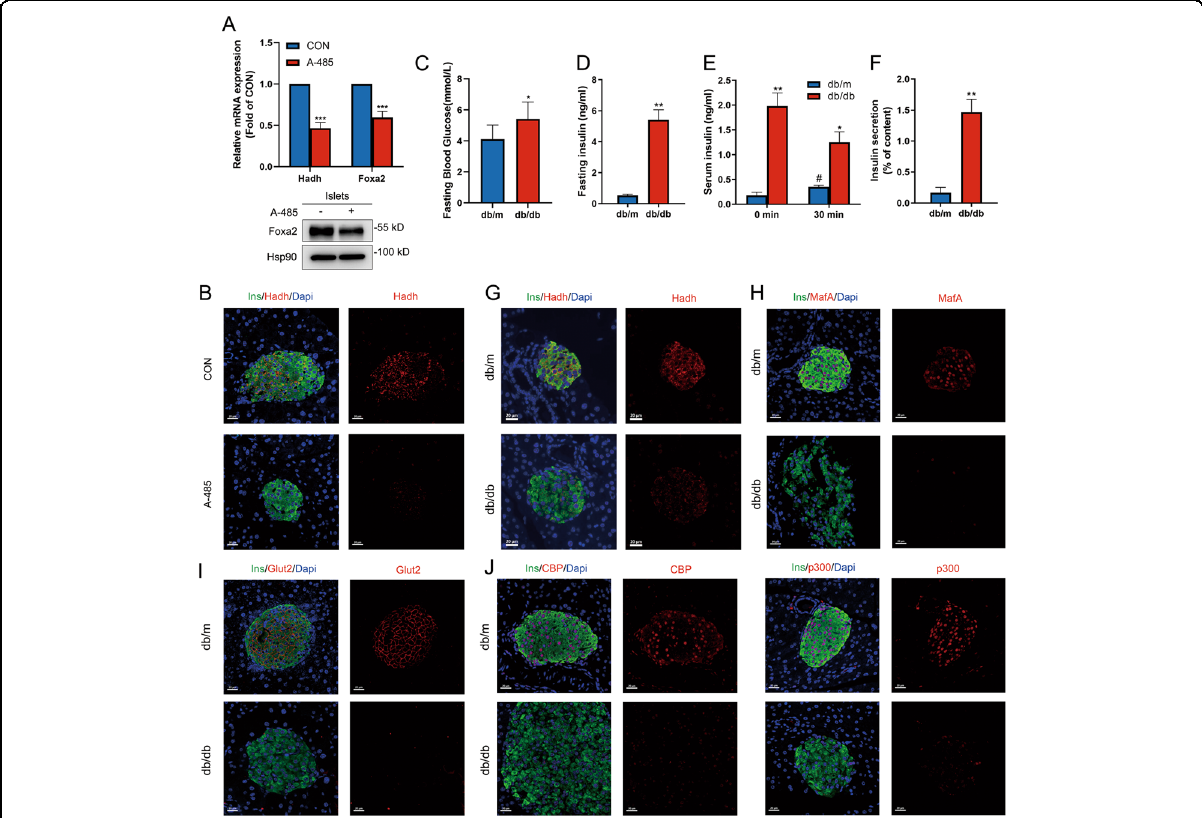
Fig. 4 CBP/p300 HAT mediates expression of Hadh responsible for basal insulin secretion. A mRNA and protein levels of Hadh and Foxa2 in isolated rat islets treated with A-485 for 16 h. B Representative pancreatic sections co-immunostained for insulin (Ins, green), Hadh (red), and DAPI (blue) from control and A-485-treated C57BL/6 mice (scale bars, 20 μ m). C Blood glucose levels of 4-week db/m and db/db mice were measured after 16 h fasting. D Fasting serum insulin levels of 4-week db/m and db/db mice. E Serum insulin levels after glucose loading in 4-week db/m and db/db mice ( n = 5). F Isolated islets from 4-week-old db/m and db/db mice were stimulated with 5.6 mM glucose for 1 h to measure insulin secretion. G – J Representative pancreatic sections co-immunostained for insulin (Ins, green), Hadh/MafA/Glut2/CBP/p300 (red), and DAPI (blue) from 4-week-old db/m and db/db mice (scale bars, 20 μ m). Data are given as mean ± SD. * p < 0.05, ** p < 0.01, *** p < 0.001 vs control group, # p < 0.001 vs 0